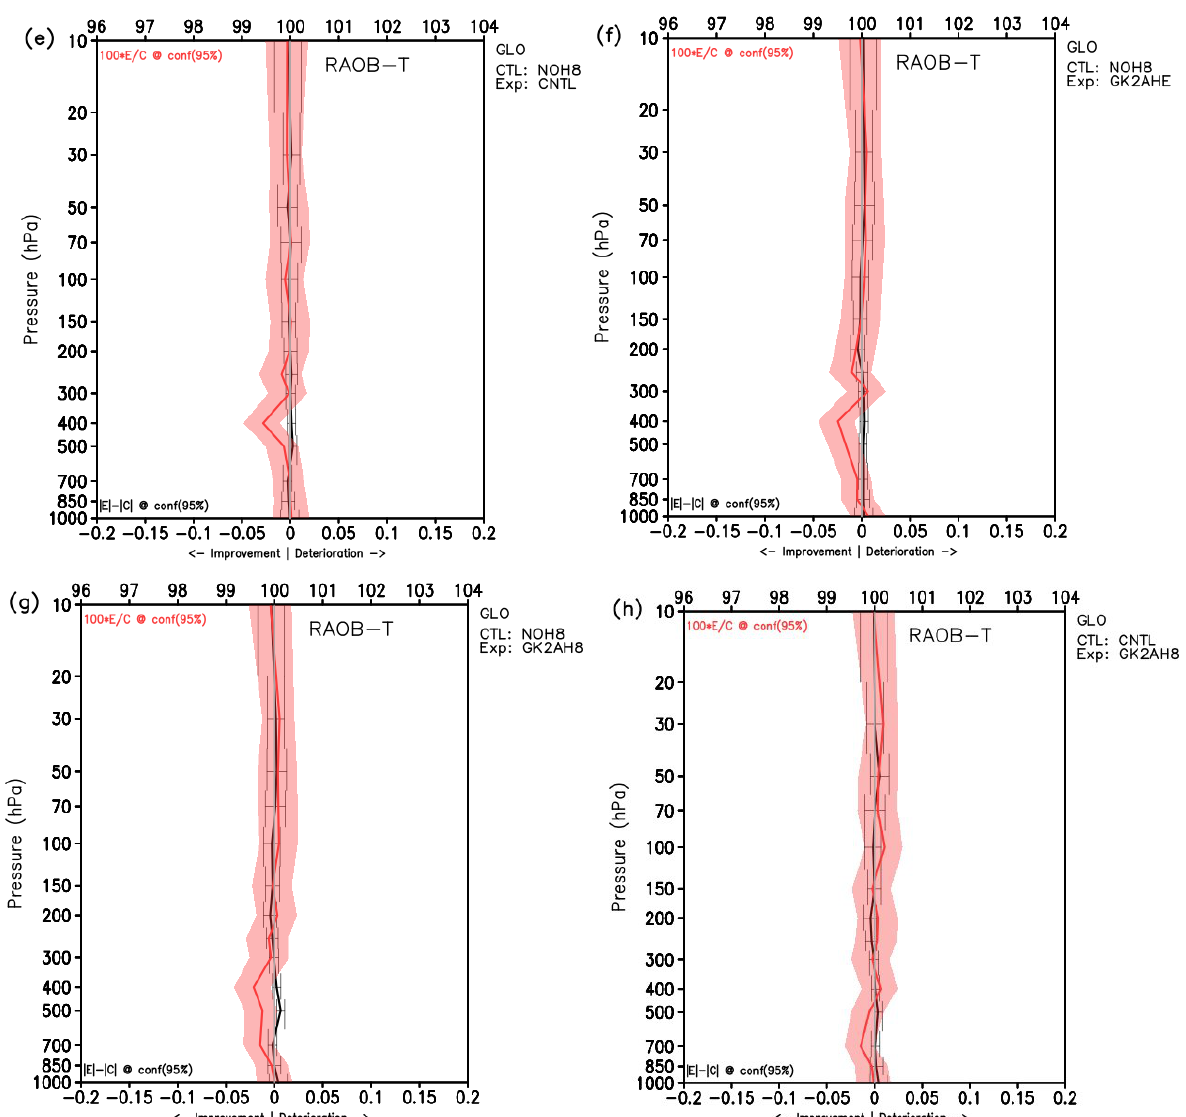
Figure 11. Comparison of globally-averaged mean absolute difference (black curve) and standard deviation ratio (red curve) for observation-minus-background fits of radiosonde zonal wind (top row) and temperature (bottom row) between given two experiments: ( a , e ) baseline versus addition of H-8; ( b , f ) baseline versus addition of GK2A; ( c , g ) baseline versus addition of both H-8 and GK2A; and ( d , h ) CNTL versus addition of GK2A. Statistical significance at 95% level shown as whiskers for mean difference and red shaded area for standard deviation; range scales for the latter are shown in the top